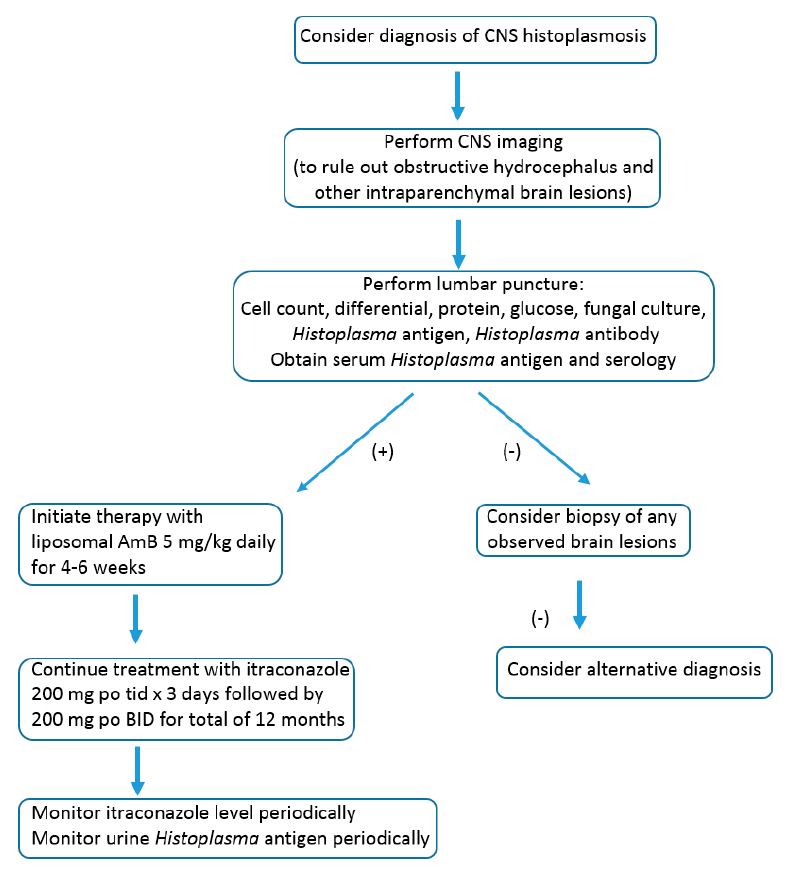
Figure 1. Testing and treatment algorithm.